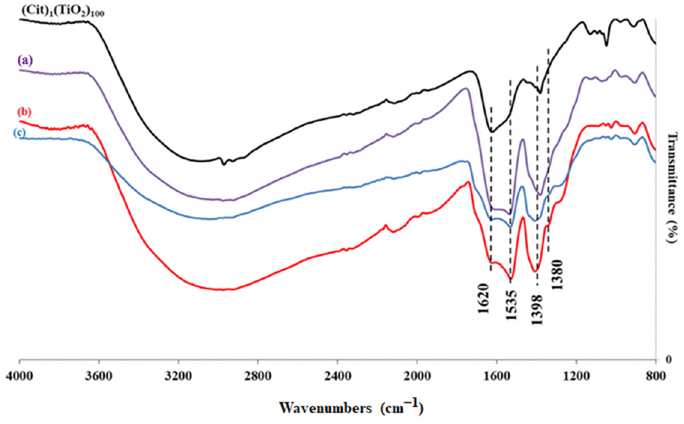
Figure 1. ATR-IR spectra of (Cit) 1 (TiO 2 ) 100 and (a) Pd/TiO 2 _20, (b) Pd/TiO 2 _50, and (c) Pd/TiO 2 _100 catalysts after drying at 70 °C for 24 h.